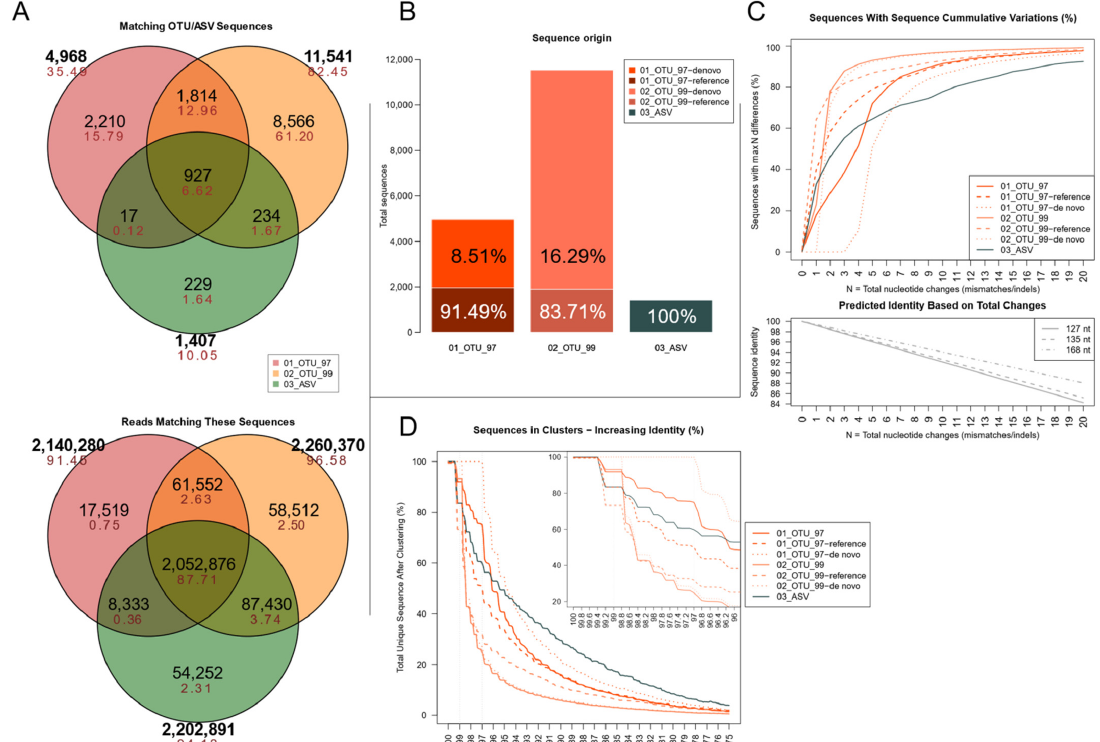
Figure 2. Sequence-level analyses showing methodological differences. ( A ) Venn diagram showing the centroid sequence overlap between the three methodological sets (top) and the corresponding total reads that match such sequences (bottom). Black = total sequences/reads; red = percentages. ( B ) Distribution of unique centroid sequences per set. Open-reference OTU sets include reference-based and de novo cluster sequences, presented as separate segments of each bar. Percentages of reads matching these sequences per set are shown for each segment. ( C ) Maximum mismatches between any pair of sequences in the sets. The x-axis (N) shows the total cumulative mismatches or indels allowed in each pairwise sequence alignment. The y-axis shows the percentage of all centroid sequences presenting a maximum of N punctual differences (how many of the centroid sequences differ in up to N total nucleotides). The graph below shows the expected sequence identity as changes accumulate at three different lengths for the V3 region. The three sets are presented with solid lines, and the OTU cluster compartments in dashed lines in matching colors. ( D ) Set resilience to clustering following an increasing sequence identity threshold. The x-axis shows an increasing identity threshold for clustering exercises. The y axis shows the percentage of sequences that remain as unique centroids after each clustering iteration. The inner panel shows the 100–96% identity thresholds in more detail.